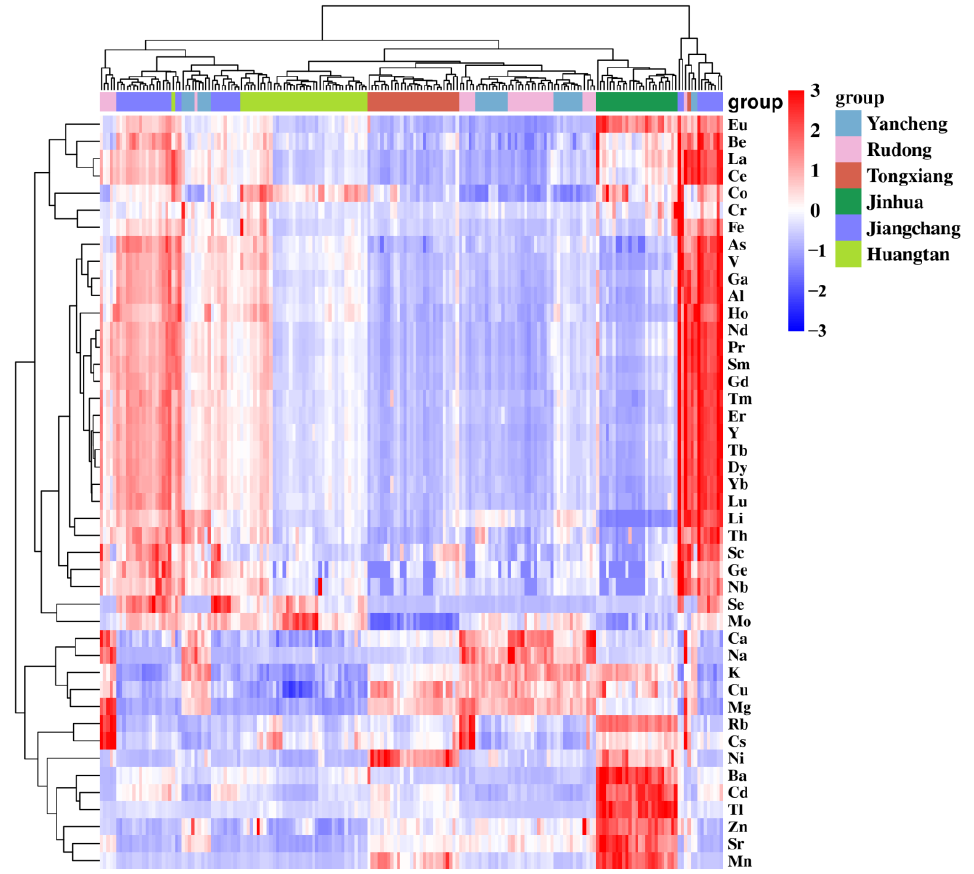
Figure 3. Heatmap visualization of the differential distribution of 44 measured mineral elements in HBJ samples from different origins.